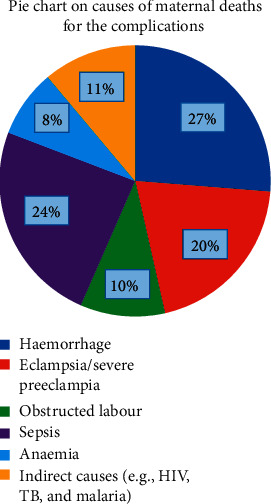
Pie chart showing causes of maternal deaths for the complications.